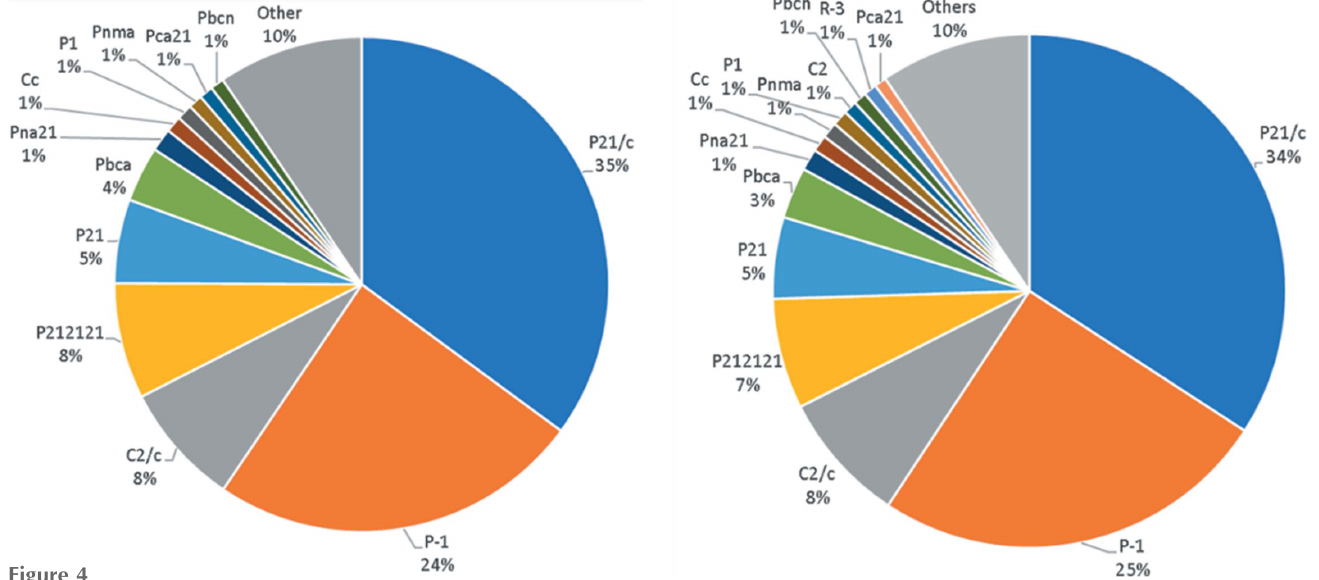
Figure 4 Pie charts showing the proportions of space groups for CSD Communications (left) and the CSD